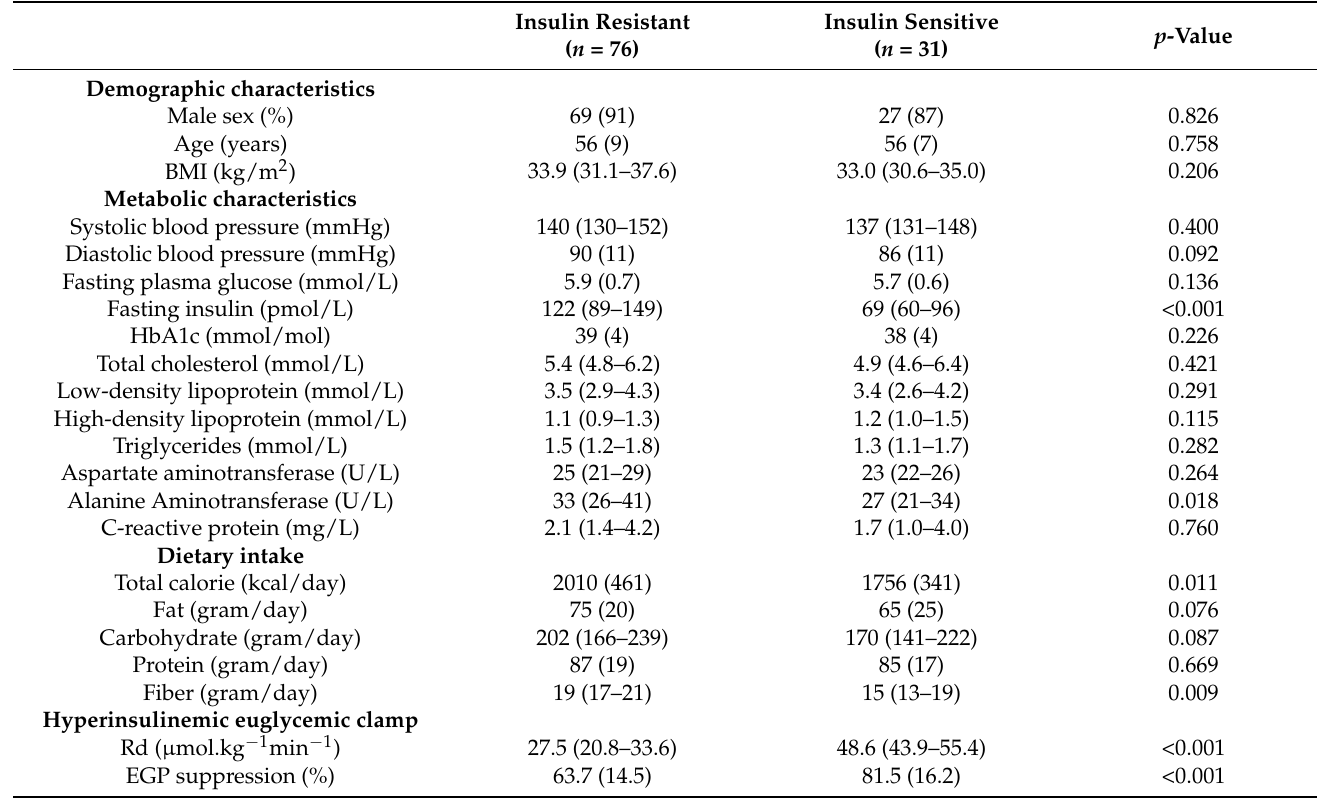
Table 1. Characteristics of study participants.